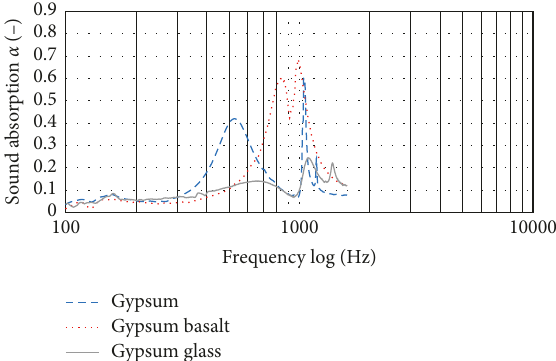
Figure 15: Absorption coefficient values obtained for gypsum.